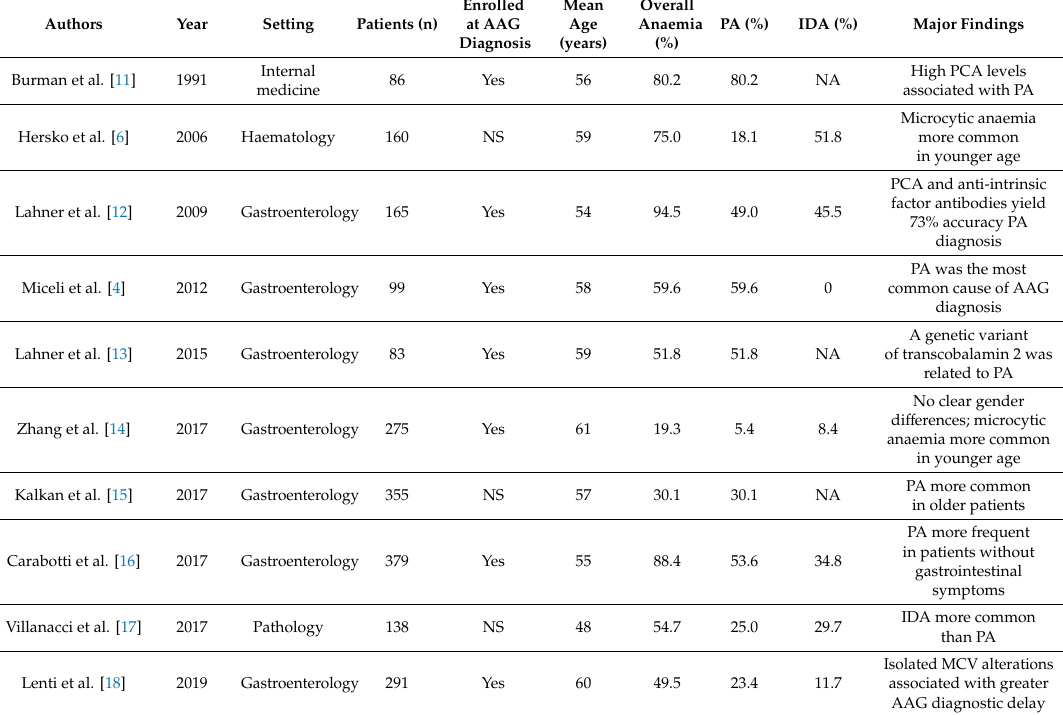
Table 1. Main studies reporting the prevalence of anaemia in adult patients with autoimmune atrophic gastritis